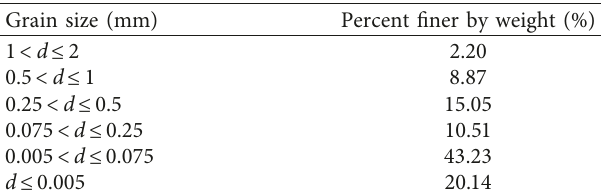
Table 2: Particle size distribution of silty